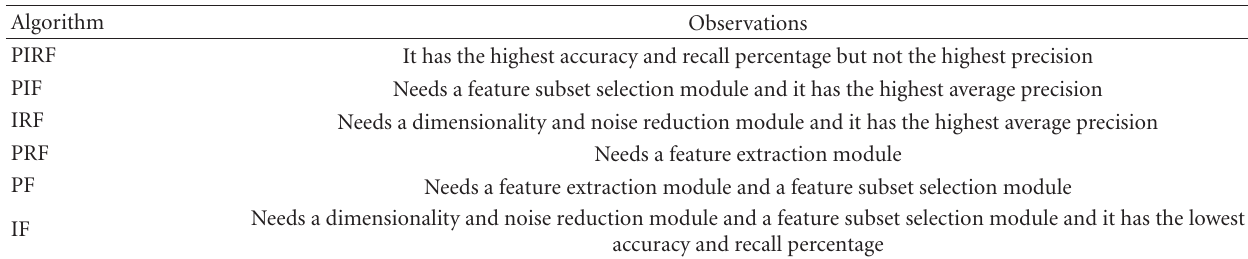
Table 5: Observations of the di ff erent developed